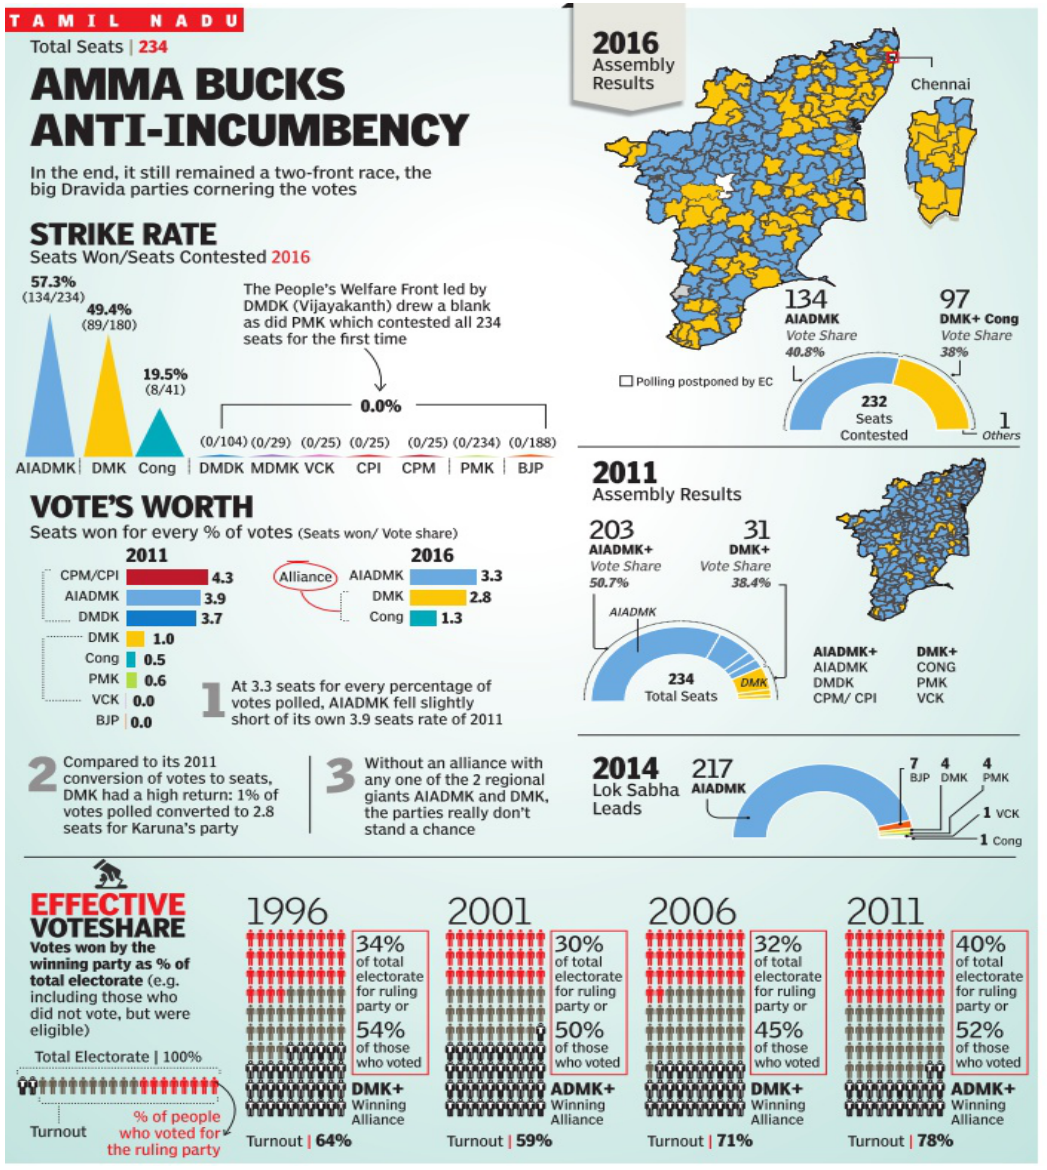
Figure 5: Tamil Nadu Assembly Elections 2016 Coverage by The Times of India 2